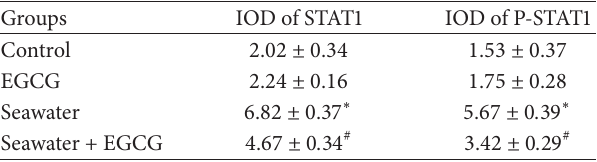
Table 2: Comparison of the quantitated IOD of STAT1 and p-STAT1 staining in lung in seawater aspiration-induced